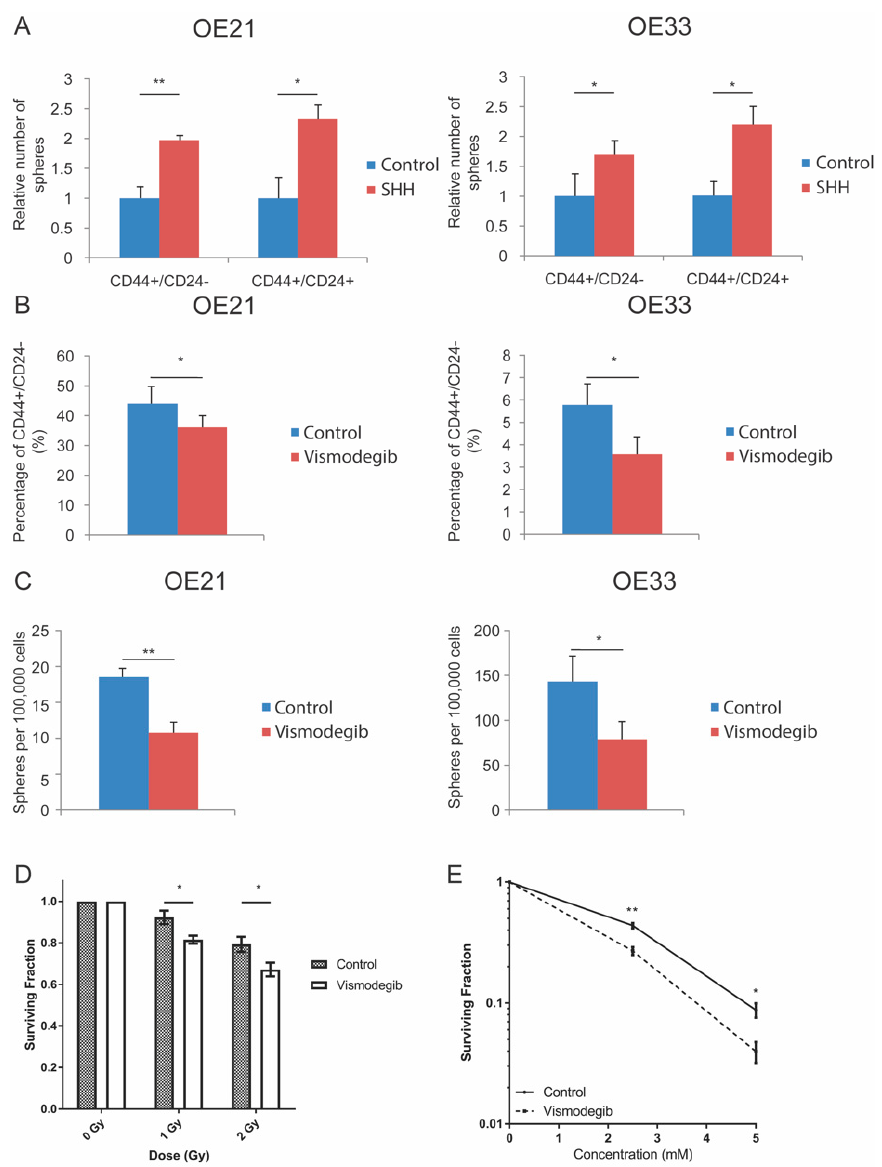
Figure 4. Sonic Hedgehog, ligand of the PTCH1 receptor up-regulates sphere formation of both CD44+/CD24 − and CD44+/CD24+ populations in OE21 and OE33 while vismodegib, a HH pathway inhibitor, deselects for the CD44+/CD24 − population, decreases sphere formation and increases radiosensitivity. ( A ) Relative number of spheres formed in OE21 and OE33 after sorting for CD44+/CD24 − and CD44+/CD24+ populations with the controls set on 1. Cells treated with SHH